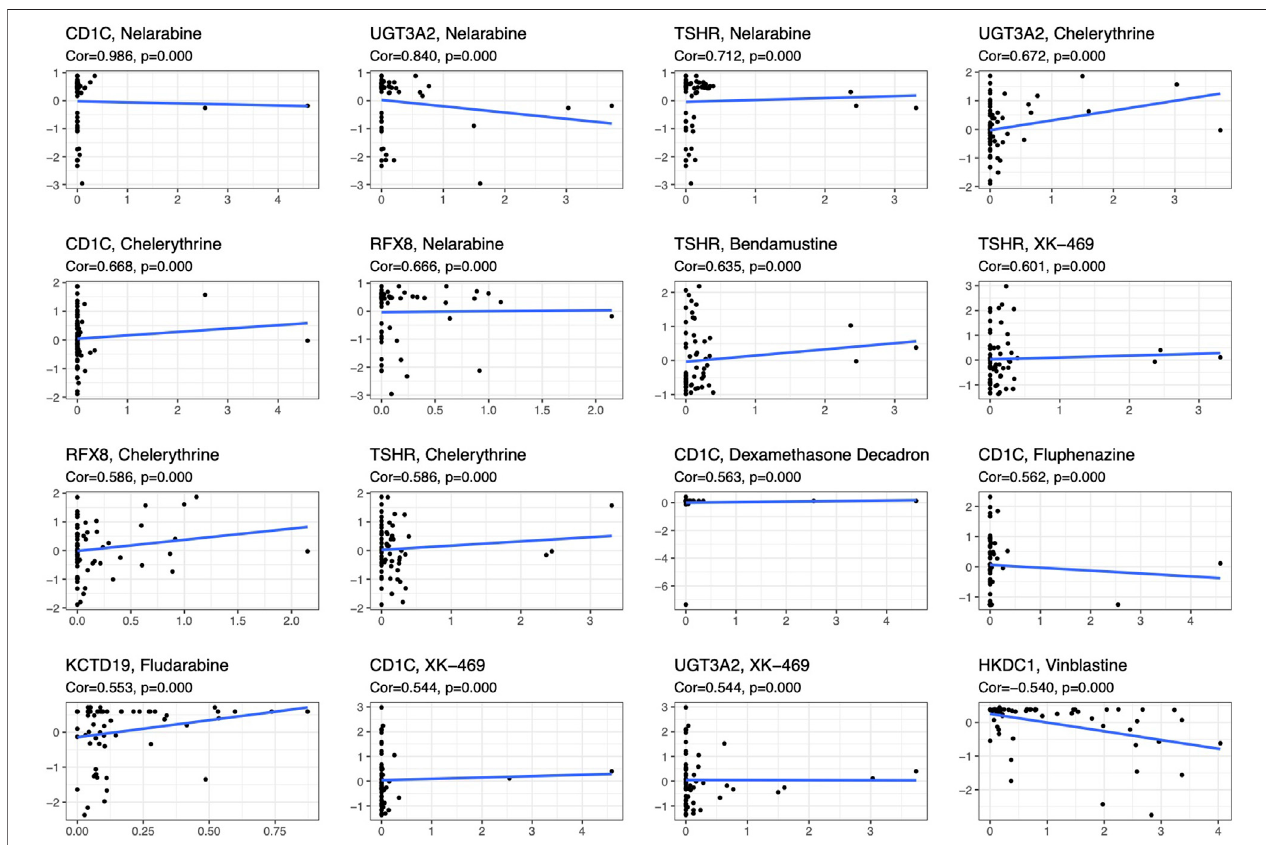
FIGURE 9 | The signi fi cant correlation between gene expression in the prognostic model and sensitivity to drugs including Vinblastine, PX-316, Nelarabine, Bendamustine, Asparaginase, Cladribine, Chlorambucil, Rebimastat, Fludarabine, XK-469, Fluphenazine, Dexamethasone Decadron, and Chelerythrine.